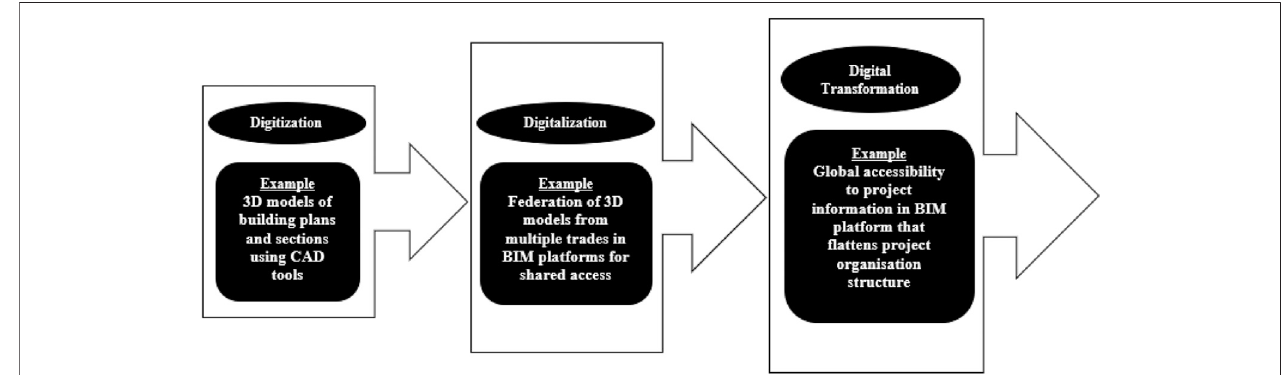
FIGURE 1 | Illustration of digitization – digitalization – digital